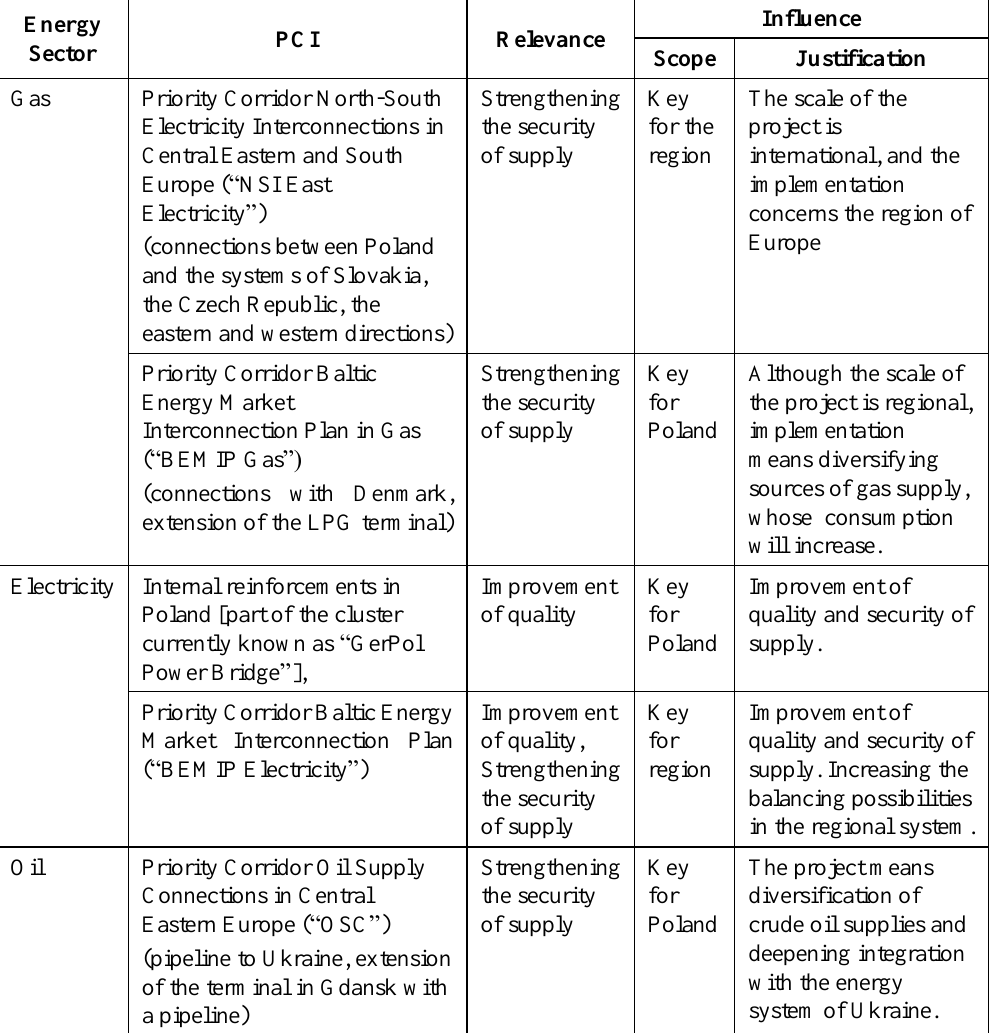
Table 5. Impact of PCI Investment on Polish and International Energy Markets (developed by the